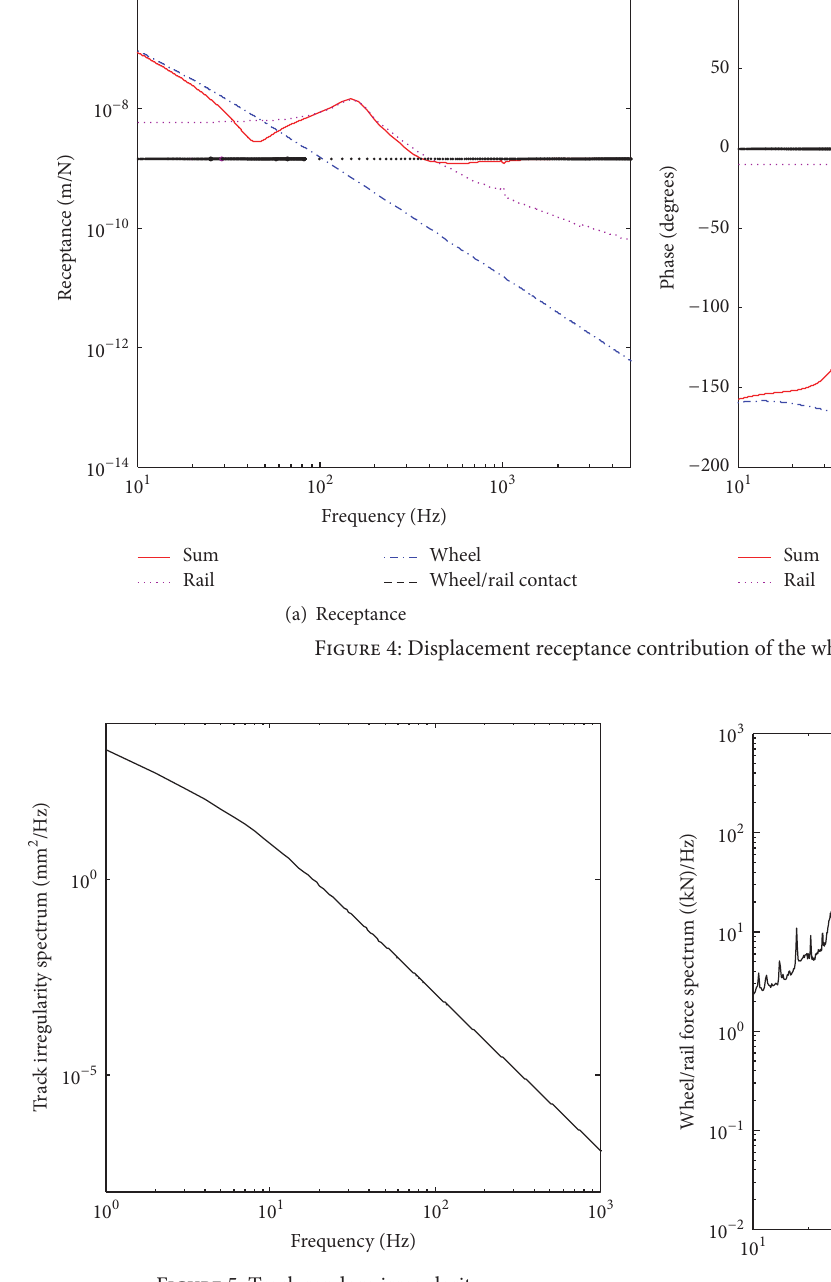
Figure 5: Track random irregularity.